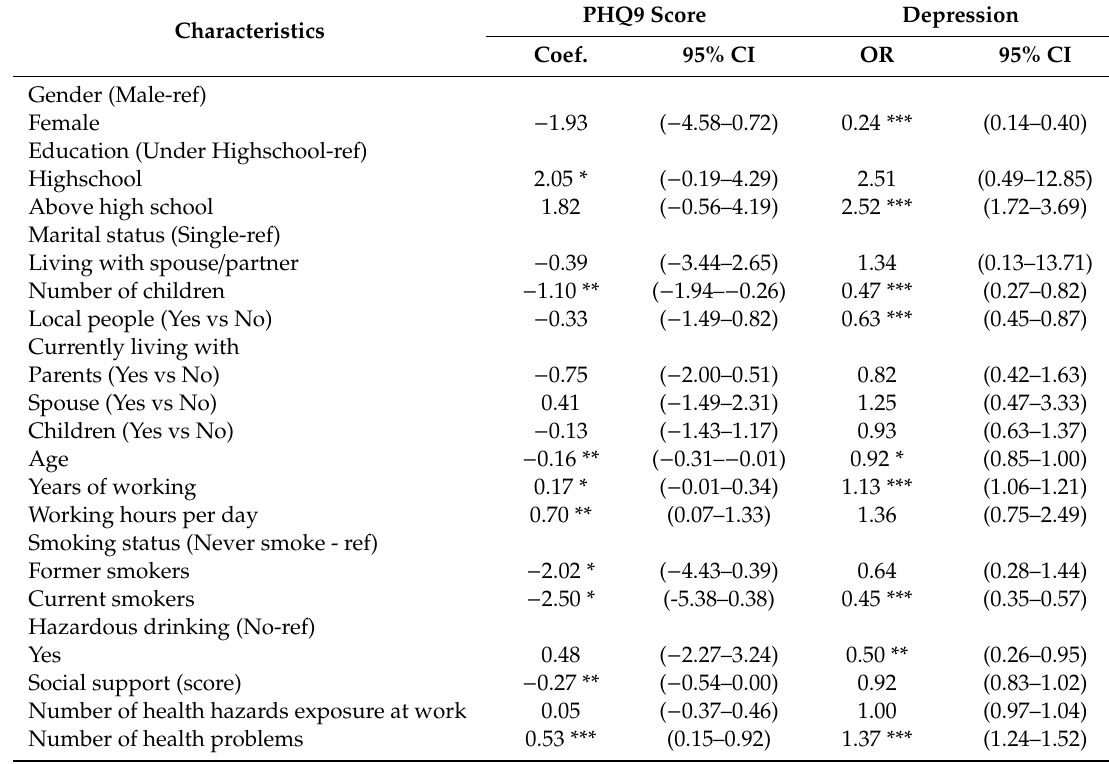
Table 5. Regression results of factors associated with depression among industrial